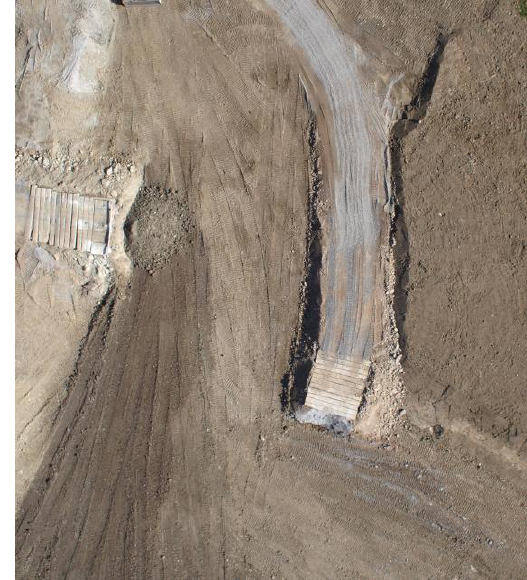
Fig. 2: Subset of an image acquired with the Olympus EP-1 mounted on the microdrones